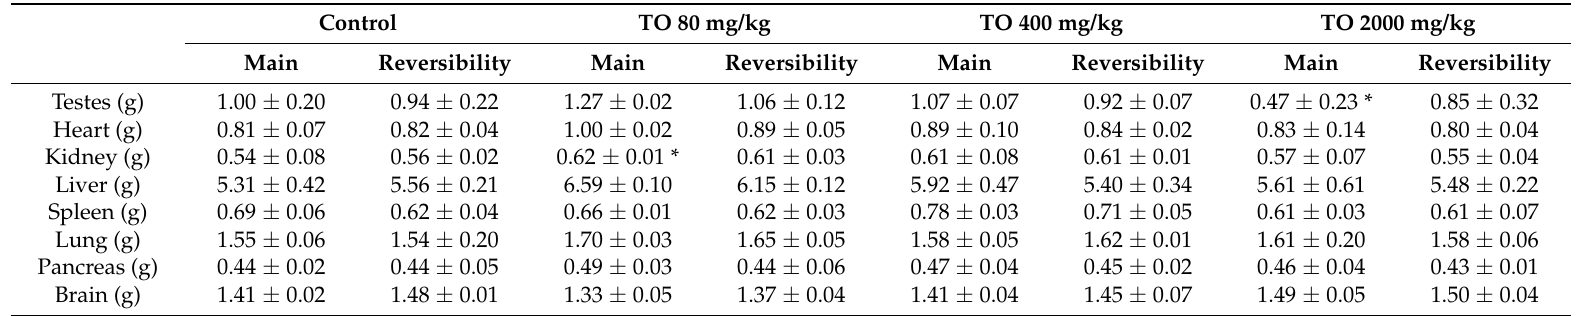
Table 2. Effect of T. occidentalis on vital organs weight (per 100 g body weight).